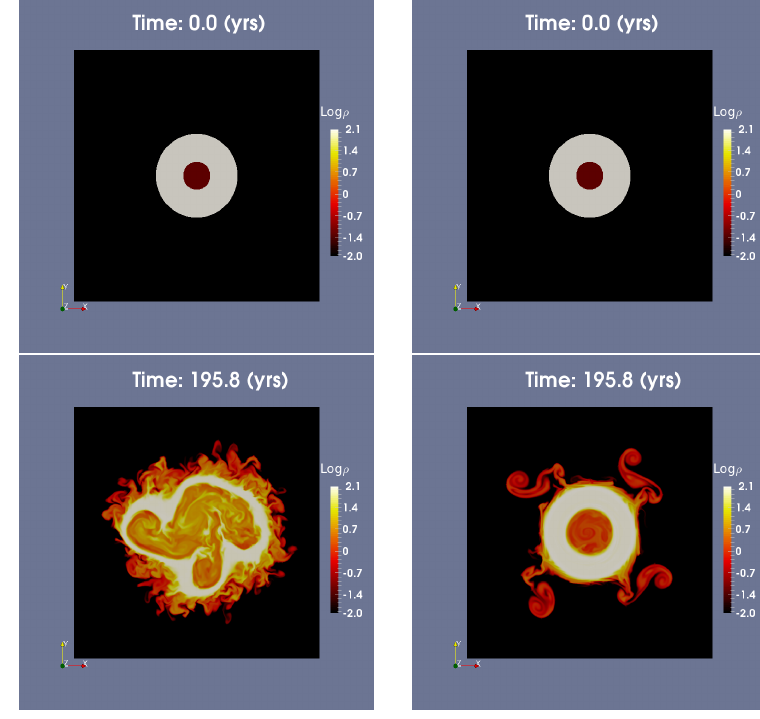
Figure 1. Left : Density map at t = 0 ( top ) and t = 3 ( bottom ) for σ = 10 − 3 . Right : Density map at t = 0 ( top ) and t = 3 ( bottom ) for σ = 10 − 1 . The shown plane is perpendicular to the jet